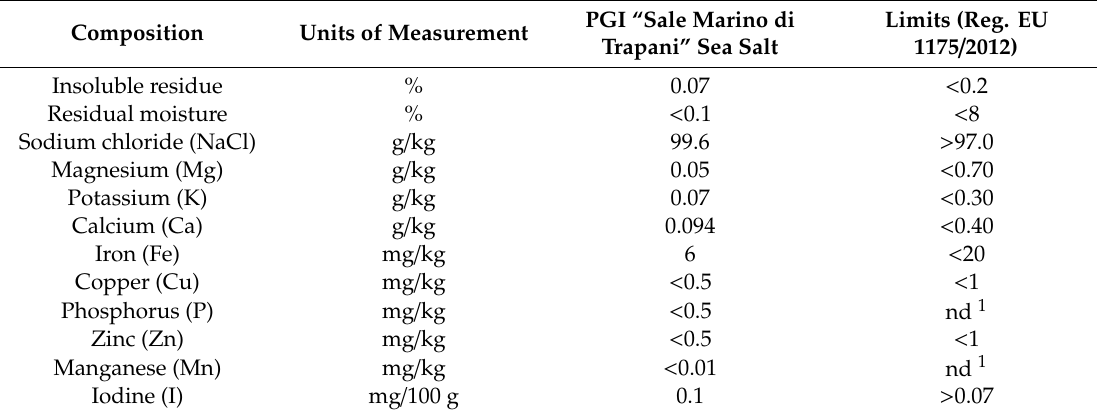
Table 3. Composition of PGI “Sale Marino di Trapani” sea